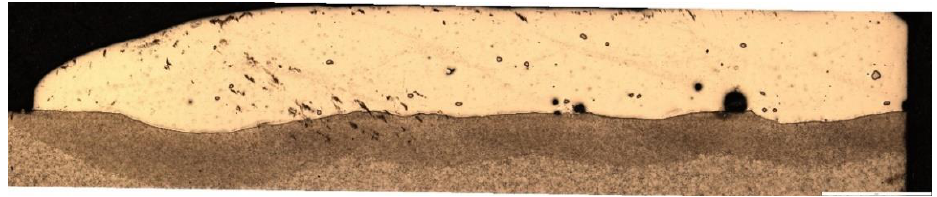
Figure 7. Macrostructure of STELLITE 6 coating cladded on 16Mo3 steel tube, average thickness 2.1 mm (×25).